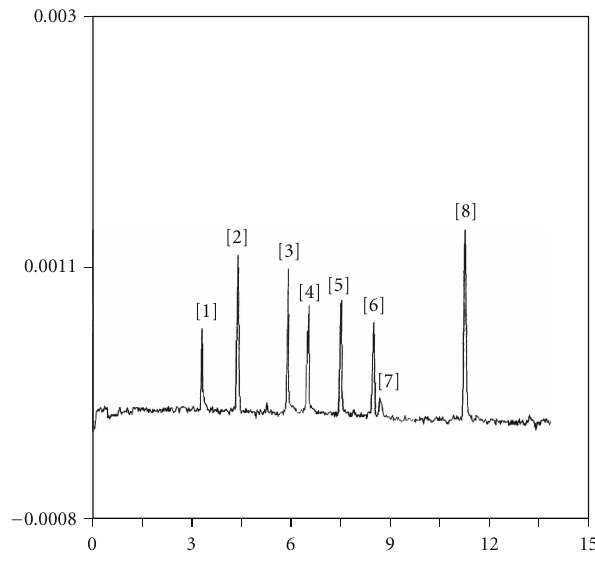
Figure 4: Electropherogram of standard mixture. Peak identifica- tion: (1) B 1 , (2) B 3 , (3) B 2 , (4) B 6 , (5) B 1a , (6) B 10 , (7) B 5 + B 2a , (8) B 9 . The vitamin concentrations are the same as in Figure 2. Experimental conditions: borate bu ff er 20 mM; pH = 9,2; V = 10kV; i = 17 µ A; T = 25 ◦ C; hydrodynamic injection t inj = 1s; fused silica capillary ID = 50 µ m; L = 44cm; l = 36cm; instrument Spectra Phoresis